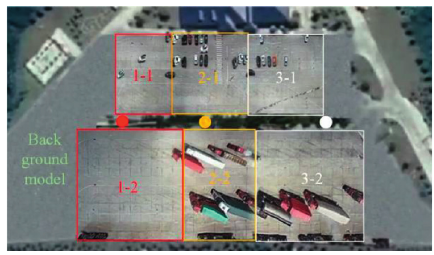
Figure 9: Surveillance model.